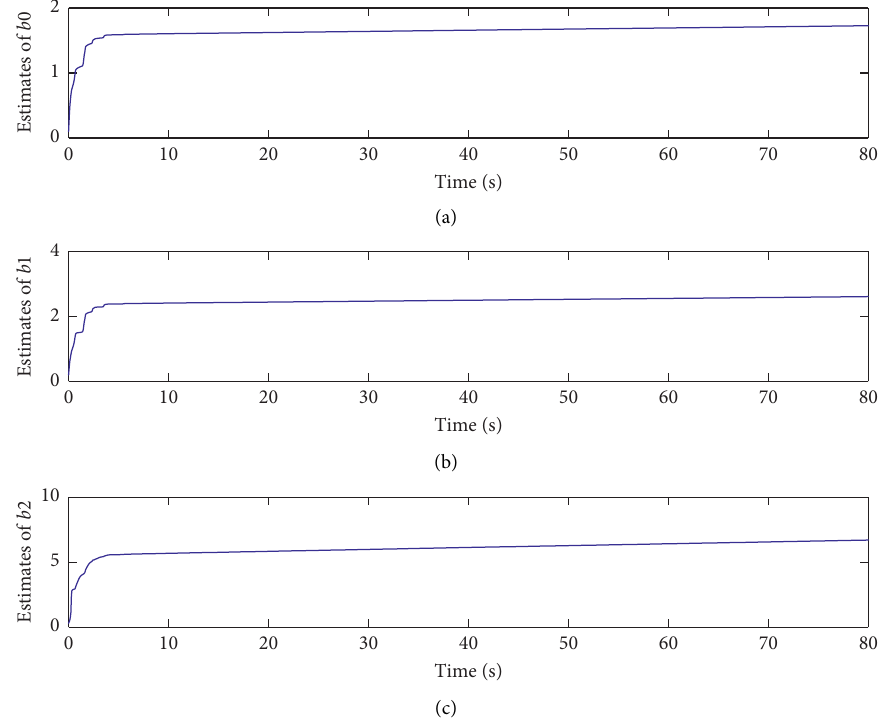
Figure 19: Adaptively estimated parameters 􏽢 b